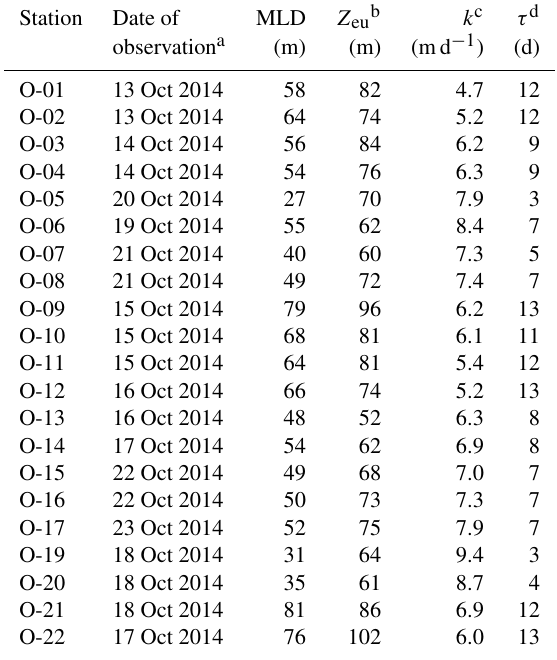
Table 1. Basic information at all CTD stations in October 2014.